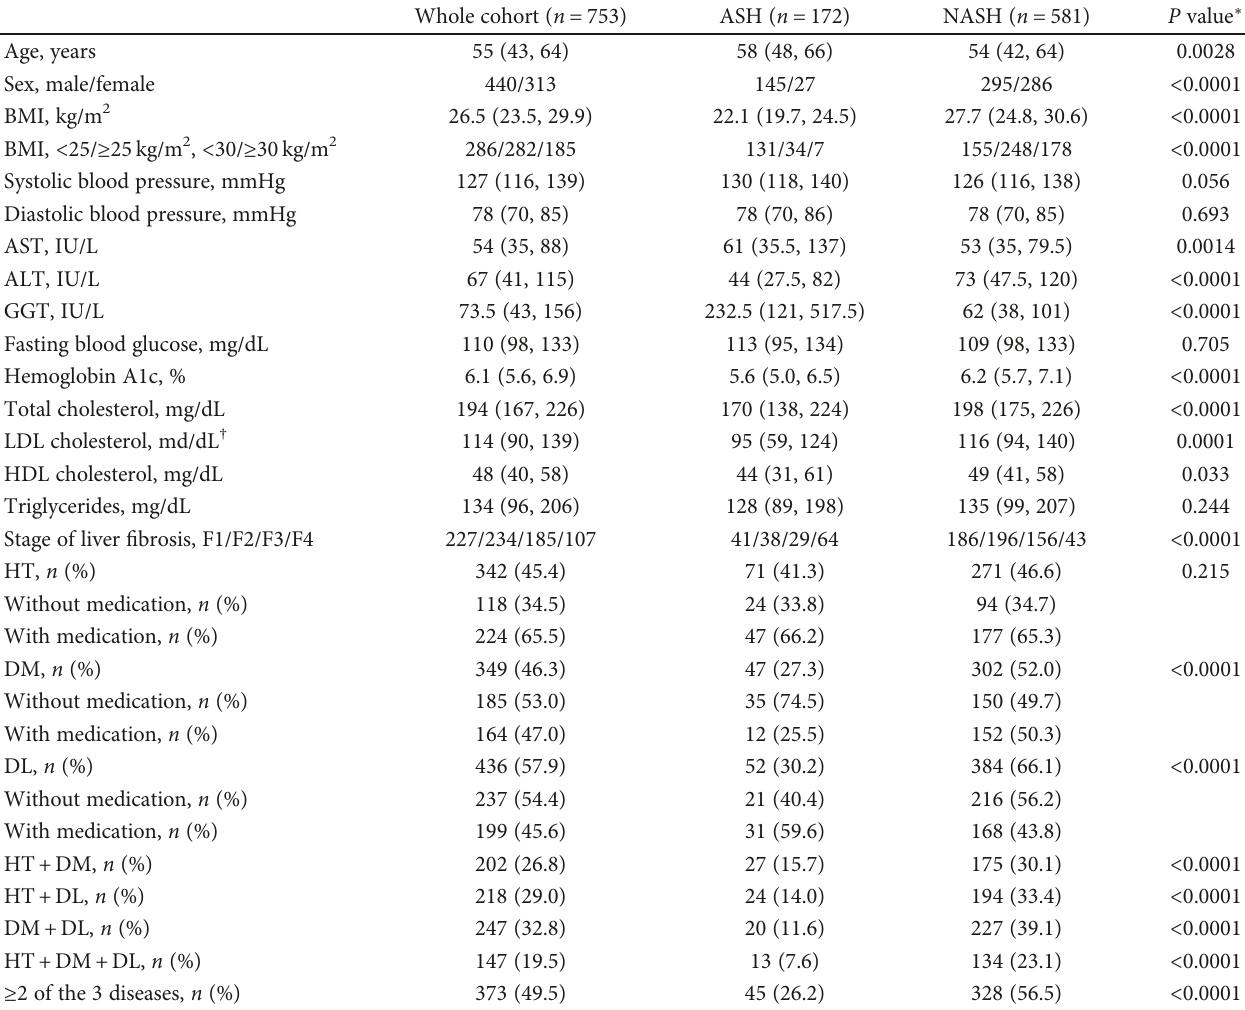
Table 1: Baseline characteristics of the enrolled